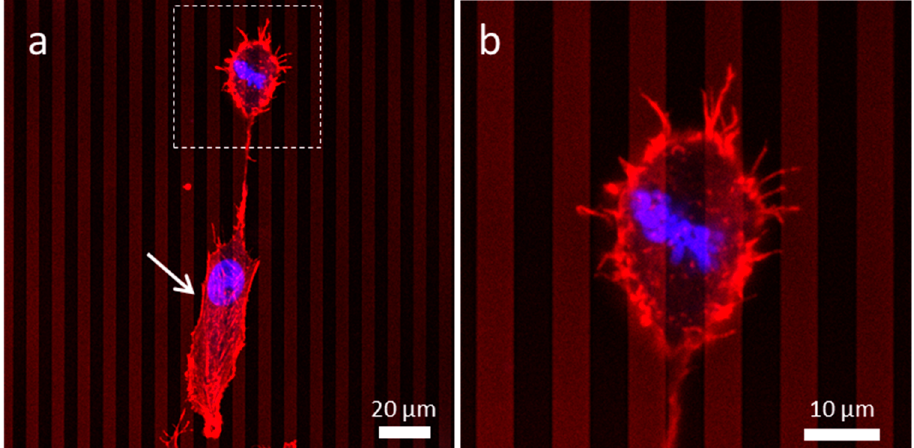
Figure 8. ( a ) Low magnification of a dividing cell possibly in the metaphase on the structure containing alternating tungsten and silicon oxide lines of an equal width of 5 µm. ( b ) High magnification image shows actin filaments protruding from the bottom half of the